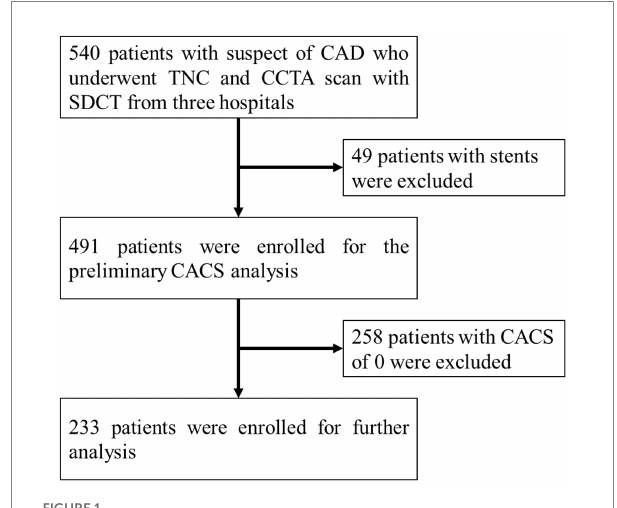
FIGURE 1 Study flowchart for the patient selection. The CAD represents coronary artery disease, the TNC represents non-contrast images, the CCTA represents coronary artery CT angiography, the SDCT represents dual-layer spectral detector CT, and the CACS represents coronary artery calcium